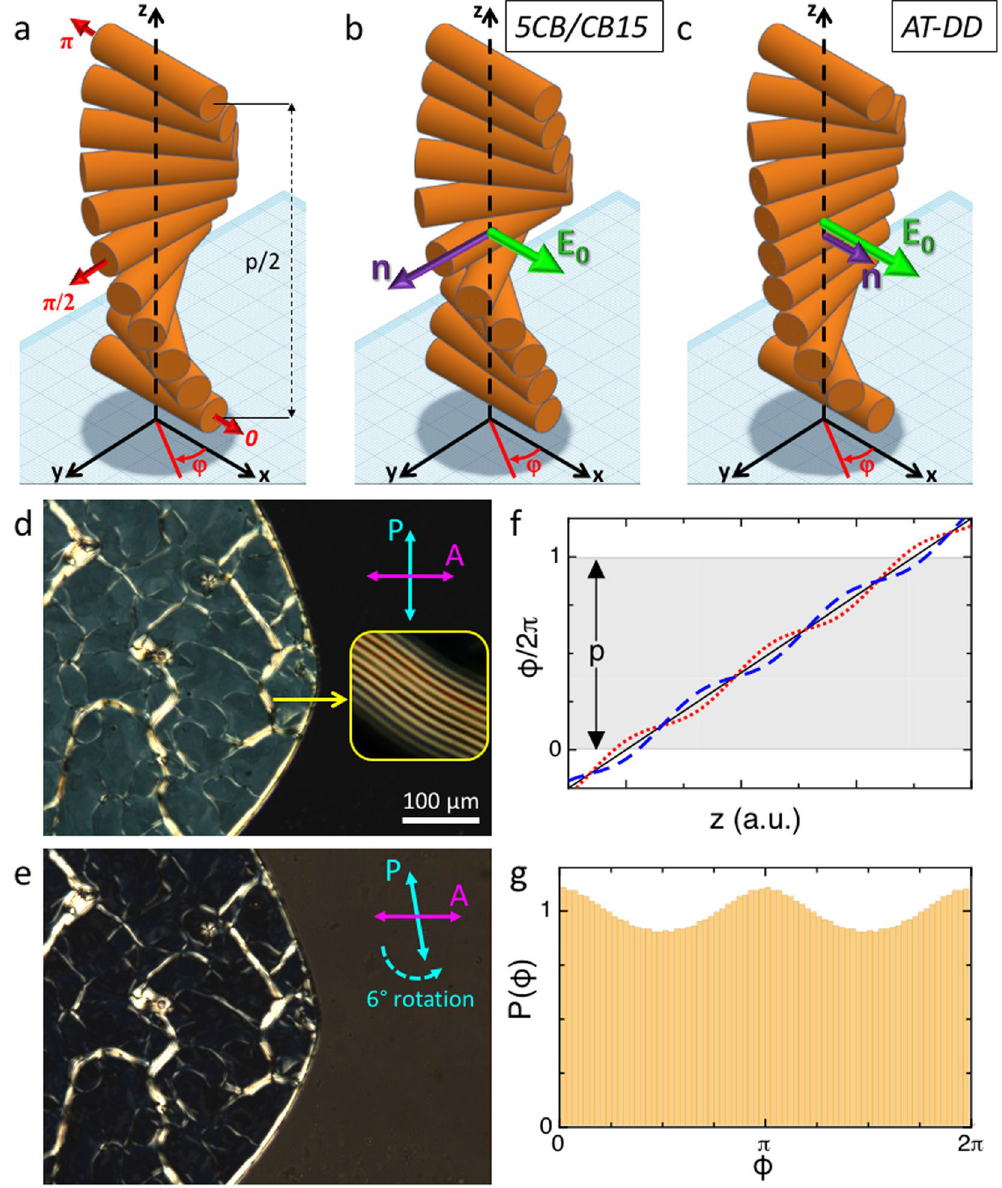
Figure 1. Description of the cell geometry and of the effects of the optical coupling. ( a – c ) Sketches of the z-dependence of the optical axis, here represented by the orientation of cylinders, in the three cases of: unperturbed planar (left handed) N * cell ( a ), coupling with the optical field in case of a N * phase with positive dielectric anisotropy such as the thermotropic LC 5CB/CB15 favoring alignment of the director along the field ( b ), coupling with the optical field in case of a N * phase with negative dielectric anisotropy such as the lyotropic AT-DD solutions favoring alignment of the director normal to the field ( c ). The drawing extends on half of a pitch. ϕ is the angle of the local director with the x axis. ( d , e ) Images in polarized transmission optical microscopy of a AT-DD cell through crossed polarizers ( d ) and through polarizers uncrossed in such a way to minimize the intensity transmitted by the DNA solution ( e ). This behavior demonstrates optical rotation. Uniform planar domains are surrounded by whitish-appearing oily streak textures. Inset in ( d ) shows an oily streak pattern at higher magnification displaying fingerprint texture. ( f ) z-dependence of ϕ in the three cases on panels a–c: unperturbed call (continuous black line), Δε > 0 (dotted red line), Δε < 0 (dashed blue line). Perturbations as in Eq. 2. ( g ) Histogram distribution of the optical axis orientation ϕ in the x-y plane for a N * coupled with positive dielectric anisotropy to an optical field polarized along x. P( ϕ ) is obtained from the profile in Eq. 2 when z is limited to an integer number of